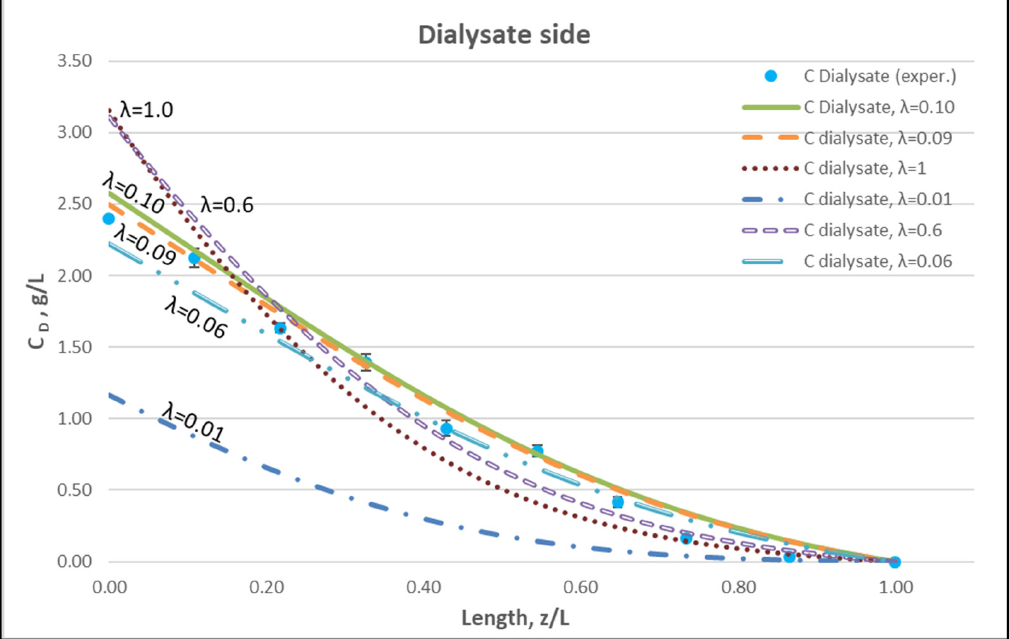
Figure 13. Dialysate-side urea concentration profile. Influence of the urea effective diffusion coefficient in the membrane (D e ) on urea mass transfer, under simultaneous trans-membrane liquid convection and solute diffusion. Case (I): Q Blood = 200 mL/min − Q Dialysate = 300 mL/min.